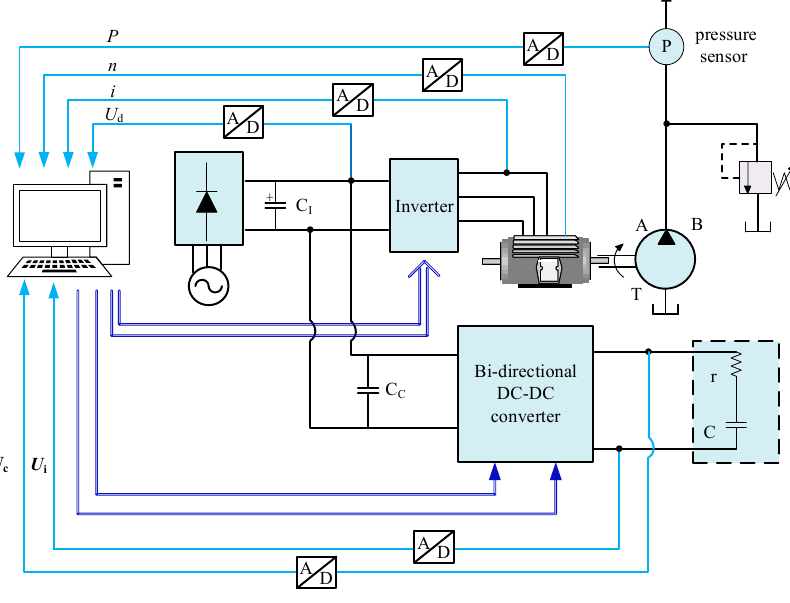
Figure 10. The system structure diagram of energy recovery and reuse.